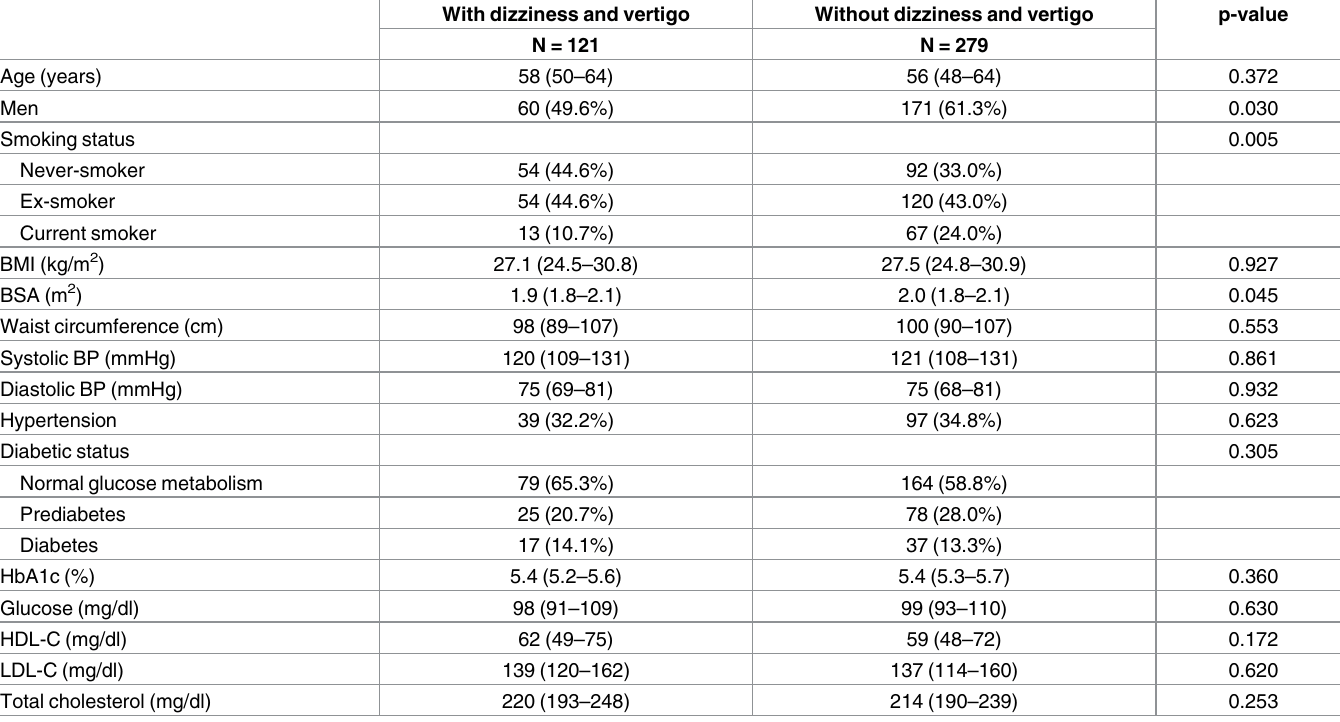
Table 1. Baseline characteristics of the study sample according to lifetime prevalenceof dizziness and